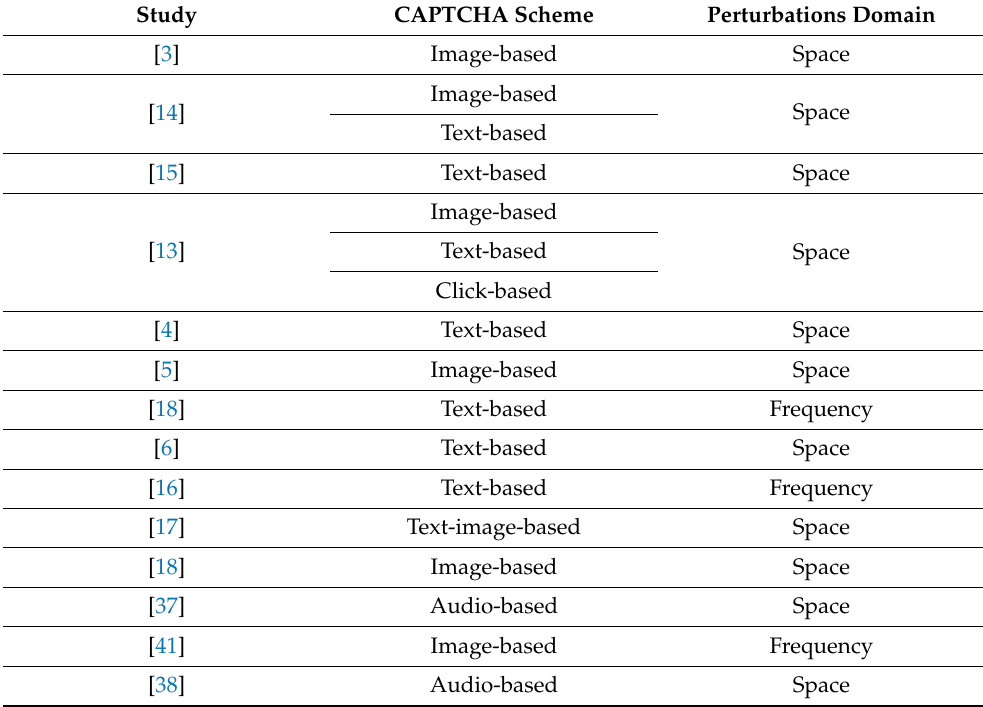
Table 6. The used perturbations domain in the state-of-the-art of